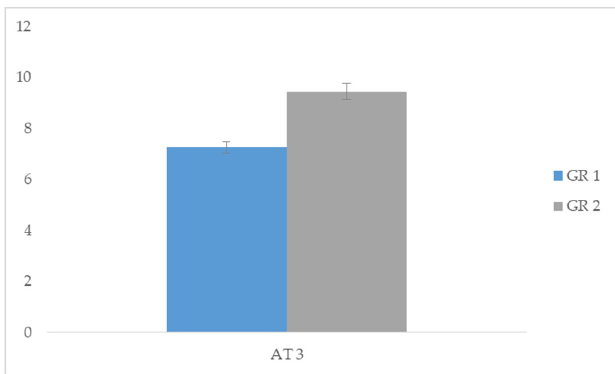
Figure 4. Comparison of AT3 task acquisition times between GR 1 and GR 2.